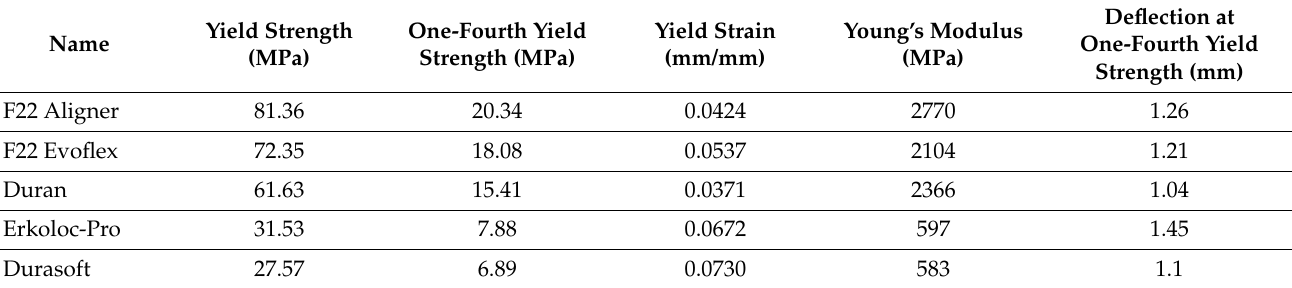
Table 2. Mechanical properties of tested materials (means).